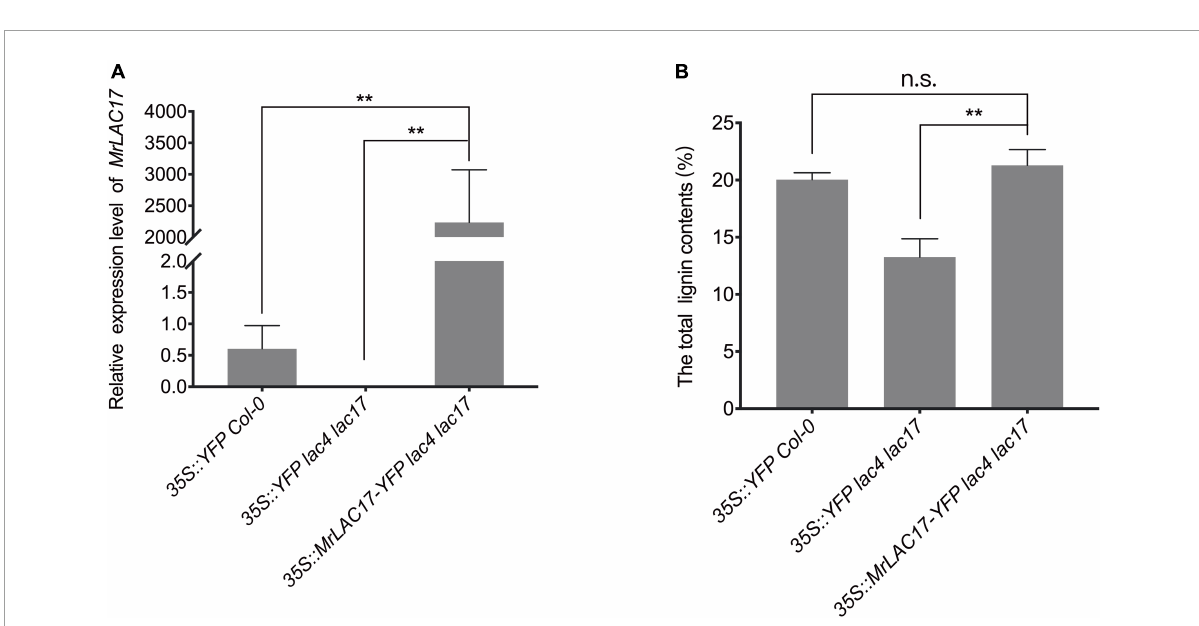
FIGURE6 MrLAC17 can complement the Arabidopsis lac4 lac17 mutant. (A) qRT-PCR analysis of MrLAC17 in Arabidopsis lac4 lac17 mutant complement, lac4 lac17 double mutants with the empty vector and Col-0 with the empty vector. The expression level in Col-0 was set to 1. AtActin was used as the internal control. (B) Lignin content in stems of Arabidopsis lac4 lac17 mutant complement, lac4 lac17 double mutants with the empty vector and Col-0 with the empty vector. In (A,B) , values are means ± S.D. of three technical replicates from three biological replicates. Asterisks indicate significant differences between the two indicated samples, as determined by Student’s t -test (** p < 0.01).